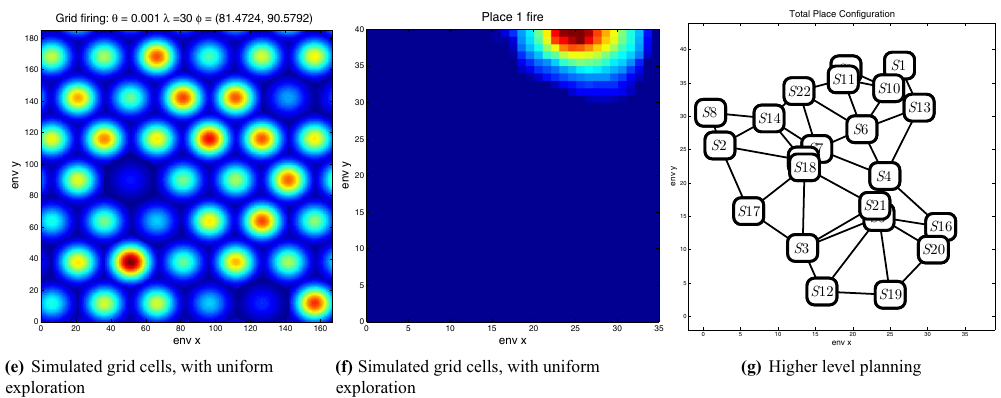
Figure 11. Graphical illustration of potential applications of the analysis. Panel ( a ) provides examples of motor primitives extracted from a maze, which could be used to simulate animal behavior in novel mazes, such as the open arena shown in Panel ( b ). In turn, the simulated trajectories shown in Panel ( b ) can be used as inputs to computational models that permit simulating grid cells (Panel ( c )) and place cells (Panel ( d )); which are different from grid cells (Panel ( e )) and place cells (Panel ( f )) generated under the hypothesis of uniform exploration. It is also possible to infer the connectivity structure that link the simulated place cells (S1 to S20 in Panel ( g )), by considering which ones are linked via motor primitives. In principle, this connectivity structure can be used to design planning